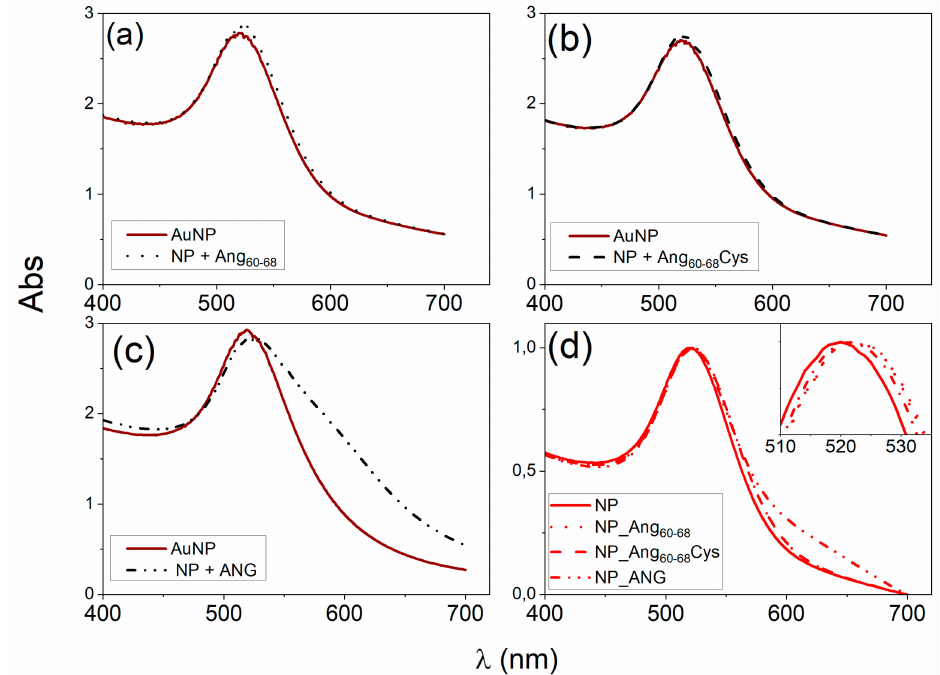
Figure 1. ( a – c ) Ultraviolet (UV)-visible spectra of gold nanopartilces (AuNPs) in the 1 mM 3-(N-morpholino)propanesulfonic acid)-Tris(2-carboxyethyl)phosphine hydrochloride (MOPS-TCEP) bu ff er (1:1 mol ratio) before and after the addition of: ( a ) 30 µ M Ang 60–68 , ( b ) 30 µ M Ang 60–68 Cys; ( c ) 100 nM angiogenin (ANG). ( d ) UV-visible spectra of the pellets collected after two rinsing steps by centrifugation (15 min at 6010 relative centrifugal force, RCF) and re-suspension in 1 mM MOPS-TCEP bu ff